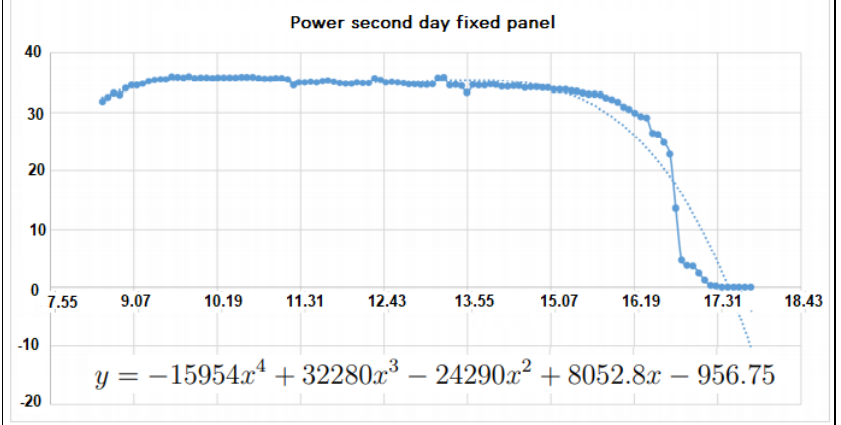
Figure 18: Graph of power generated second with fixed panel. Source: Authors, (2022).